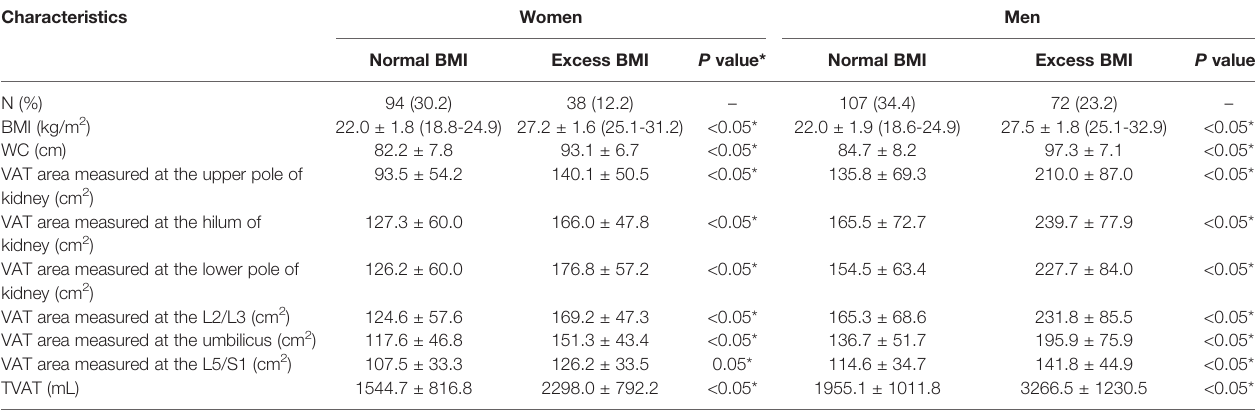
TABLE 4 | Differences in VAT area and TVAT volume in different gender and BMI group.